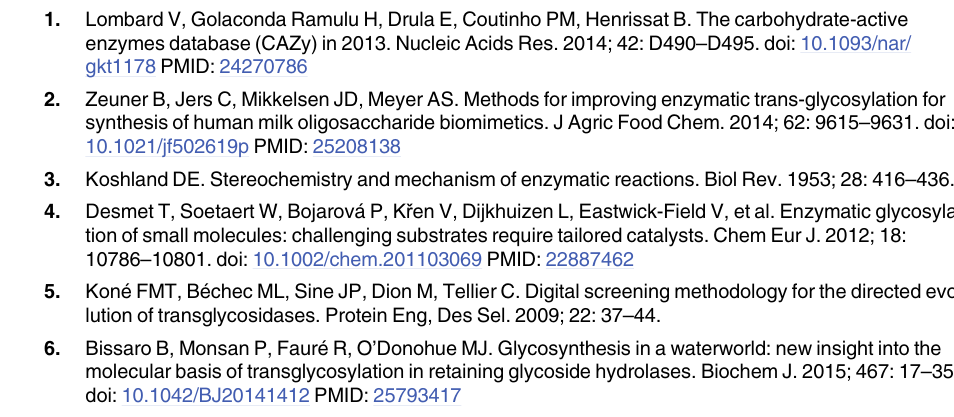
S1 Table. Sequence IDs of the sequences identified in the initial database screening. 46 sequences were identified using the O xRDR search motif (Box 1). Of these, 30 were rejected before homology modeling due to redundancy or the fact that they were already known Trypa- nosoma trans-sialidases (TS), including TcTS. Redundancy indicates that there was more than one sequence from the same organism (sequence identities were (cid:2) 77% and is given in paren- theses), and one from each was selected for homology modeling. The remaining 16 sequences were subjected to homology modeling (S2 Table). S2 Table. Sequence IDs of the 3D alignments of the 15 sequences selected for homology modeling (HM). Homology models were aligned to the TcTS crystal structure (PDB 1S0I) for evaluation against selection criteria 1 and 2 (Fig 2; S1 Fig). The reason for rejecting a sequence after homology modeling is indicated. Falling for criterion 1: Does not contain all nine con- served active site residues (S1 Fig). No template: No template available for homology modeling with HHPred. Candidate name in bold (SialA, SialP) indicates that these are sequences fulfill- ing the two selection criteria and selected for expression. Sequences of SialM and SialH were added after BLAST of sequences of SialA and SialP: of the two closest homologues for each, these two fulfilled both selection